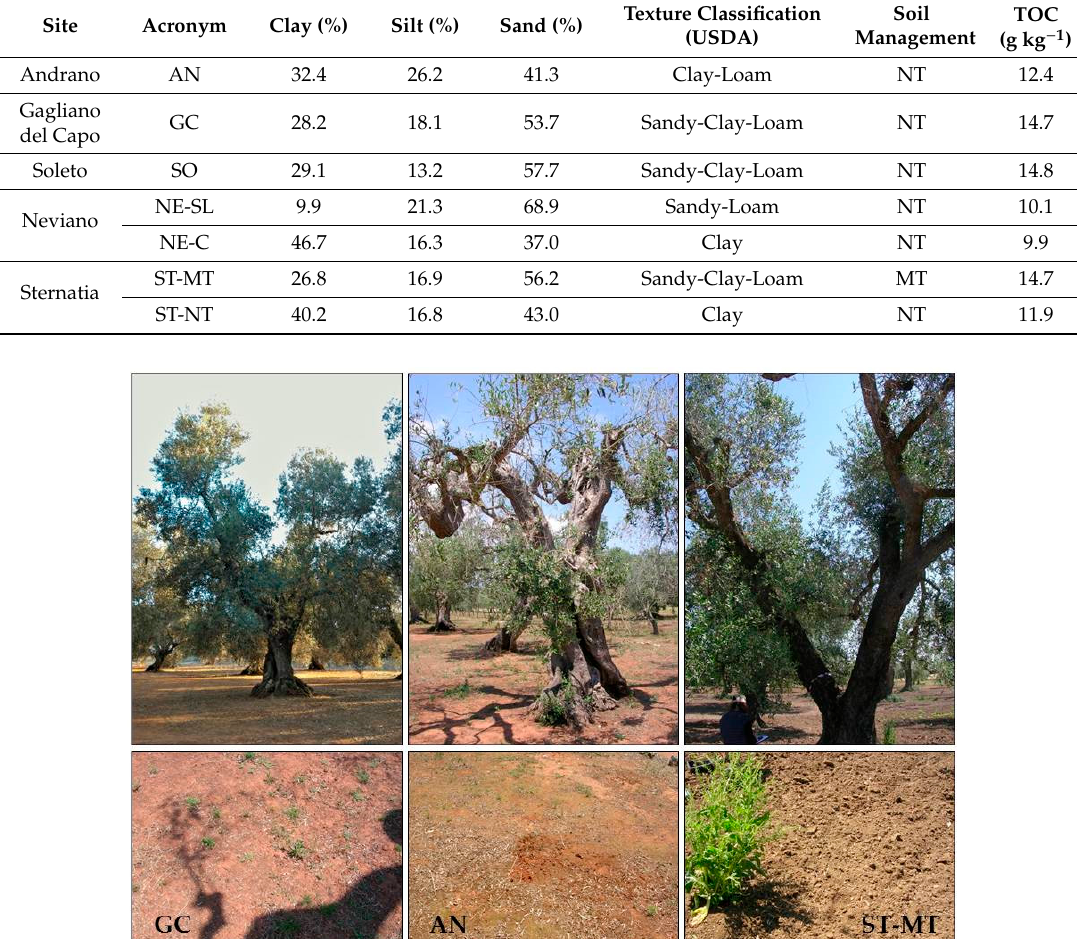
Table 1. Clay, silt, and sand contents (0–0.1 m depth) according to the USDA classification and soil total organic carbon content (TOC) for each site and soil management (minimum tillage, MT, and no-tillage, NT).